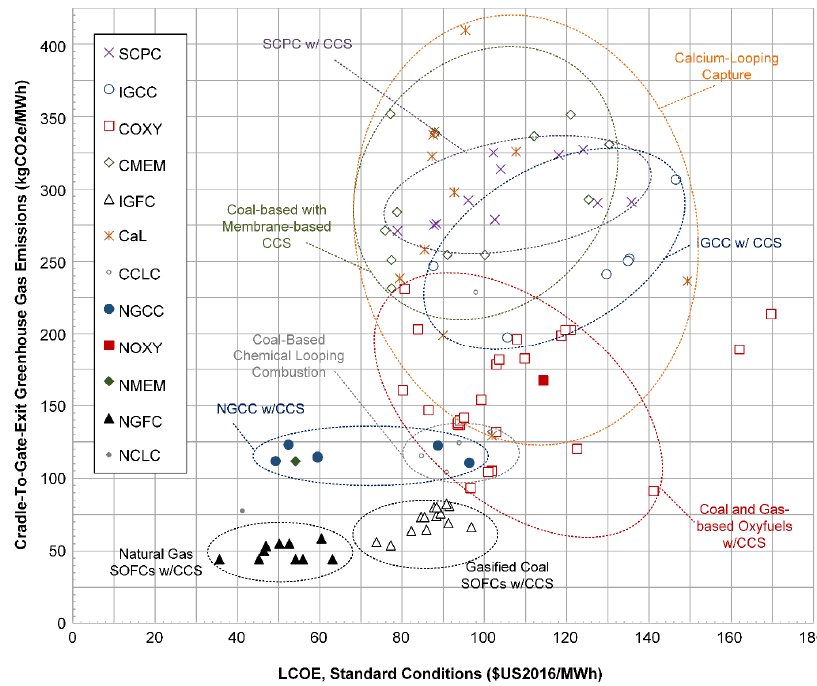
Figure 13. Scatter plot of the calculated LCOE at standard conditions of each plant vs. the calculated life cycle greenhouse gas emissions, but using average fuel prices for 2016 instead of as-reported prices. Ellipses are drawn as a visual aid only and do not specifically identify outliers. Processes 2017 , 5 , 44